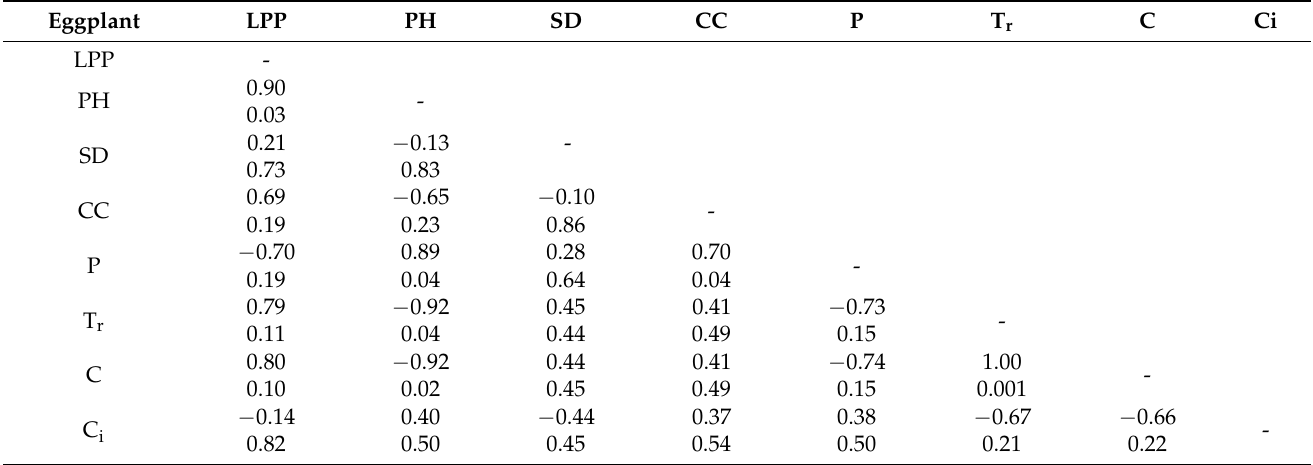
Table 3. Pearson correlation coefficient (upper value) and p -value (lower value) for the eggplant infested host